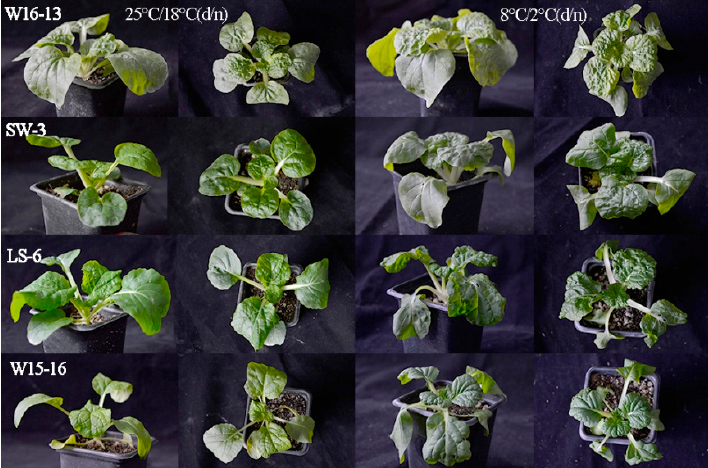
Figure 8. Variation in the response of four genotypes of wucai exposed to lowtemperature stress. Cont: 25/18 °C (d/n); ET: 8/2 °C (d/n).